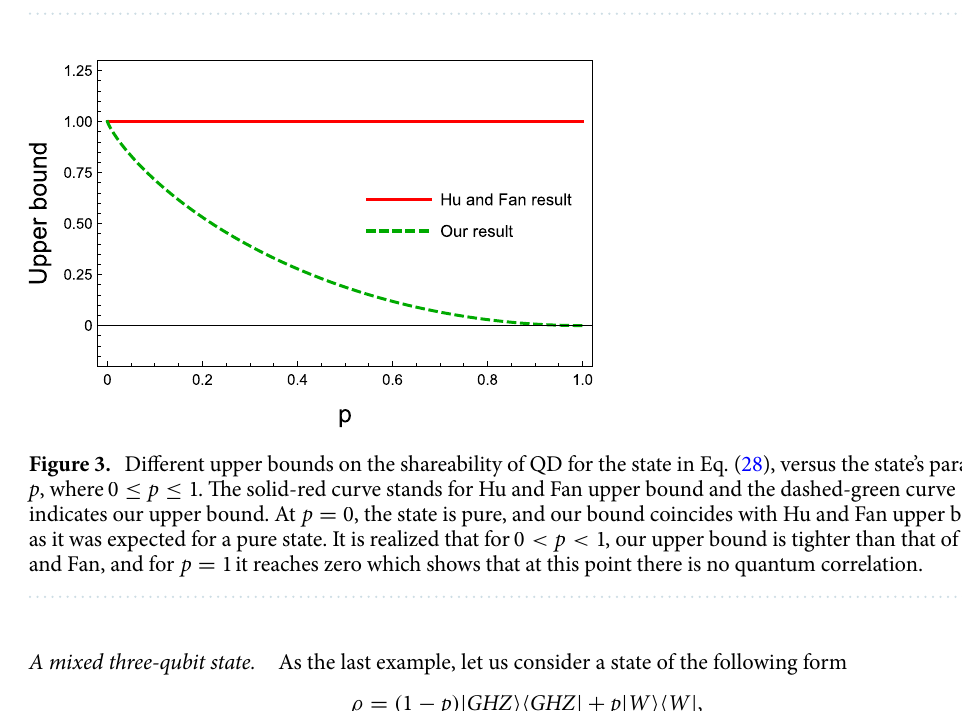
Figure 2. Different upper bounds on the shareability of QD for the state in Eq. (27), versus the state’s parameter θ , where φ π/ 4 . Since the state is pure, our upper bound will be the same as the upper bound of Hu and Fan, = which is plotted in the figure.